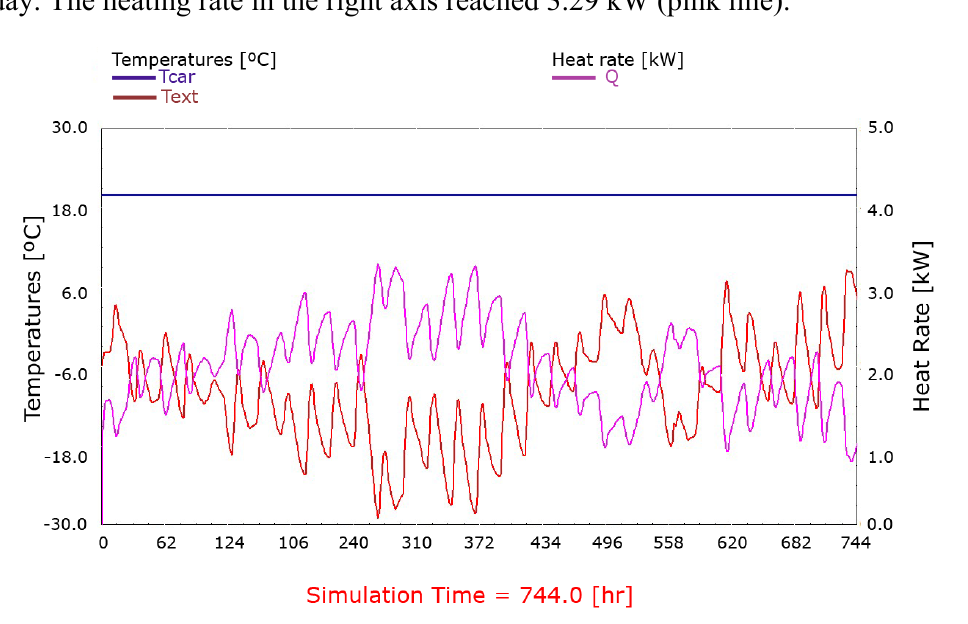
Figure 8. Simulation results for Berlin in January. Room temperature of the caravan (blue line) was fixed to 20 °C, and the ambient temperature (red line) reached − 28.9 °C on the 12th day. The heating rate in the right axis reached 3.29 kW (pink